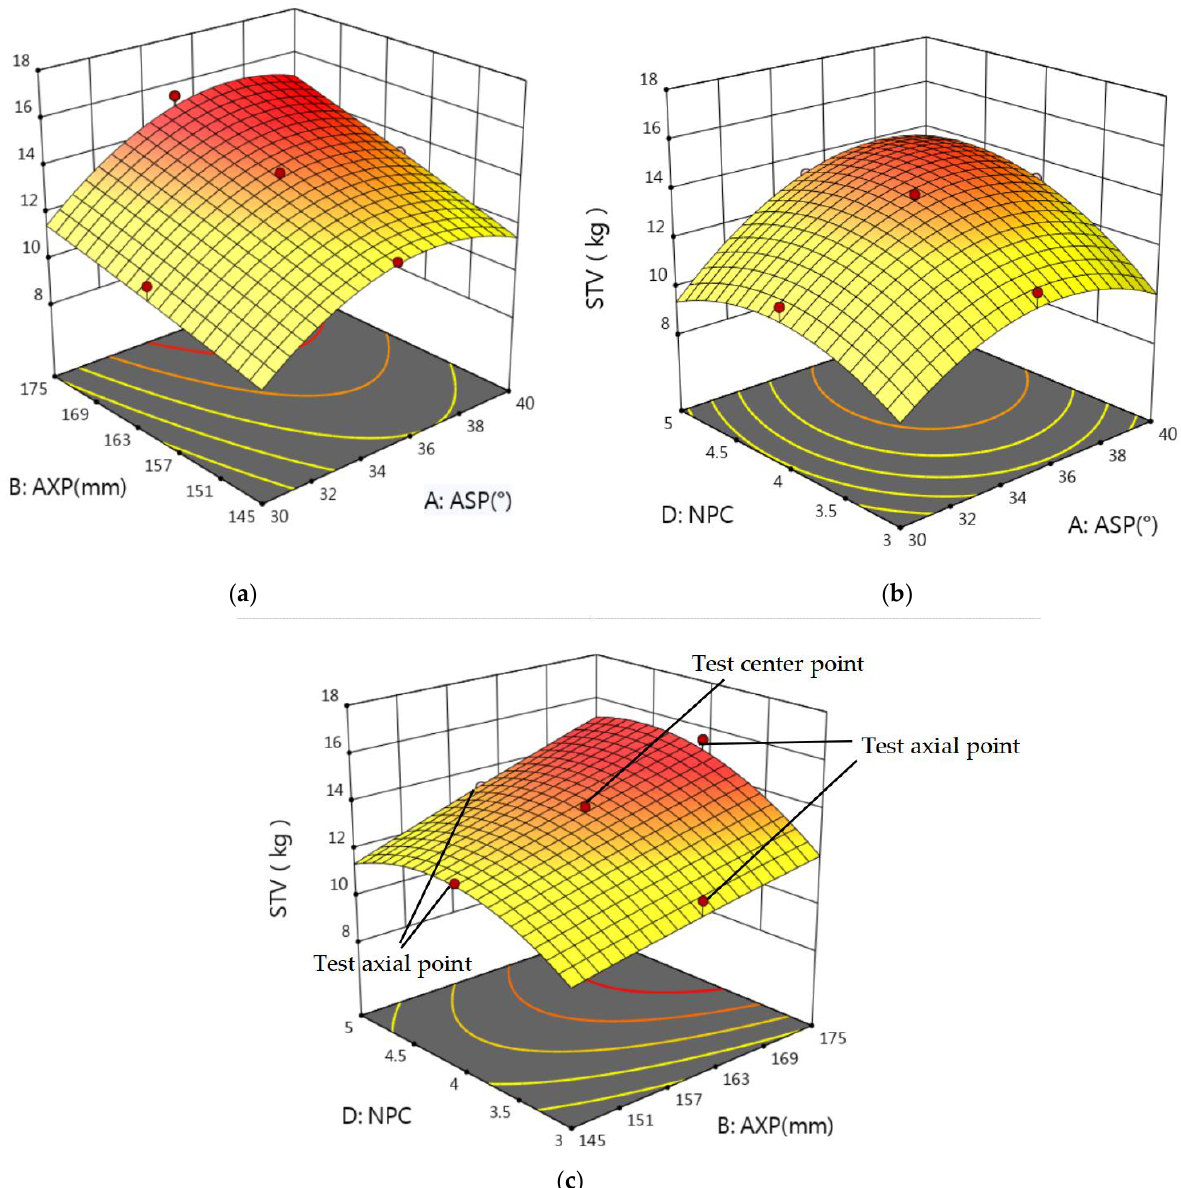
Figure 8. ( a ) AB factor interaction surfaces. ( b ) AD factor interaction surface. ( c ) BD factor interaction surface.